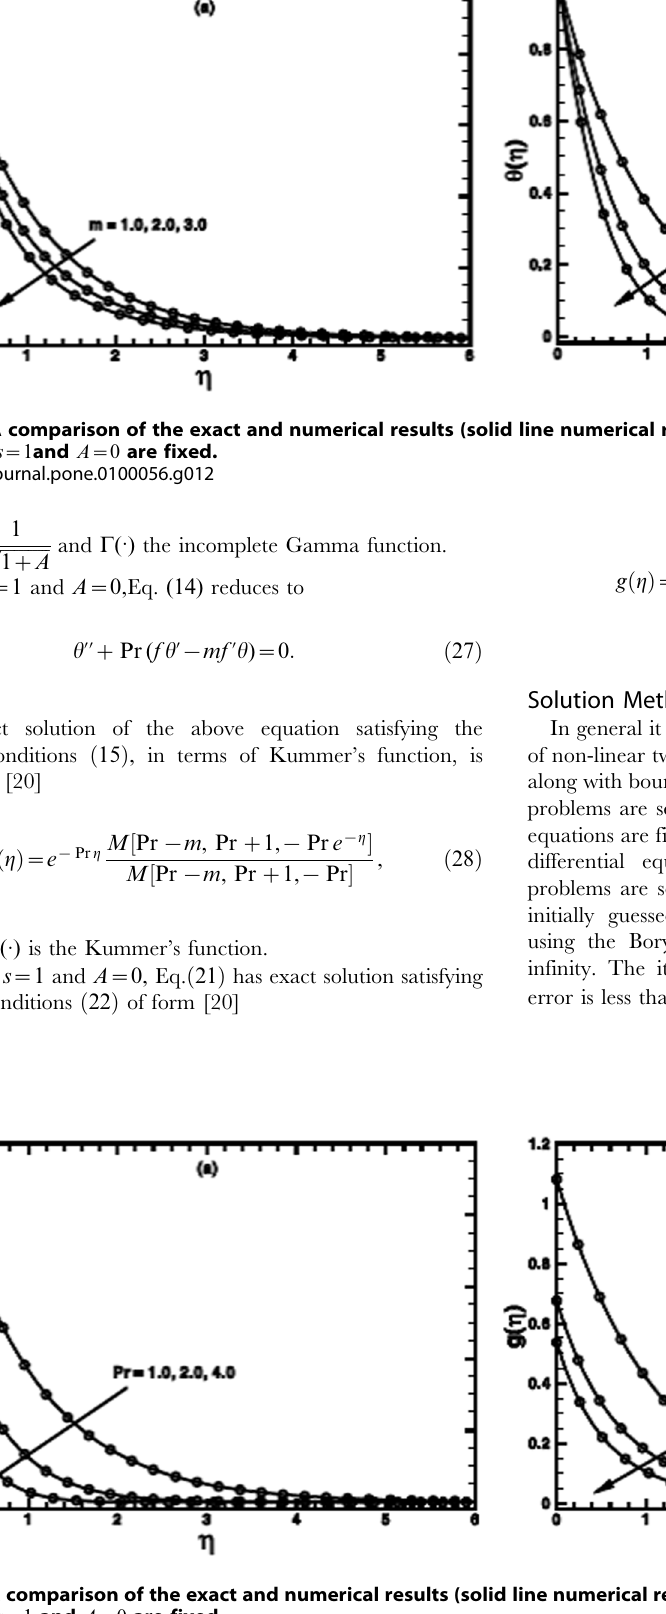
Figure 13. A comparison of the exact and numerical results (solid line numerical results and open circles exact results) in PHF case when n ~ 1 , s ~ 1 and A ~ 0 are fixed.